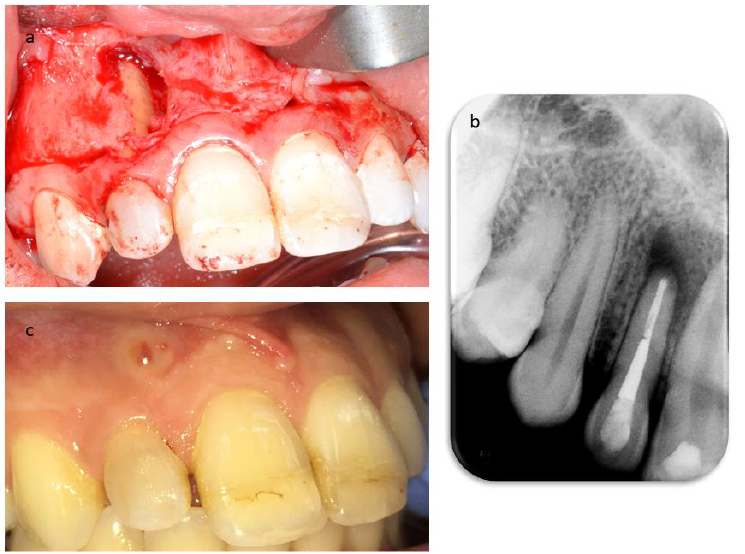
Figure 6. ( a ) Intra-operative picture of the surgical endodontic treatment. ( b ) Post-operative periap- ical radiograph. ( c ) Clinical examination of the patient at one month after surgery showing the per- sistence of the stoma.